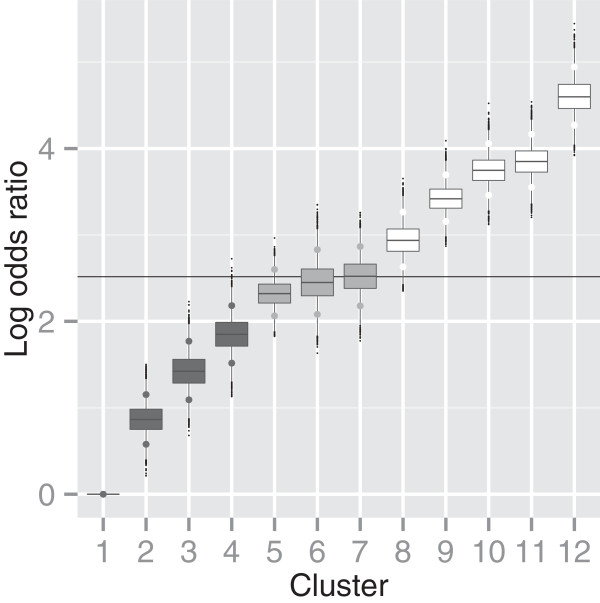
Log odds ratios of clusters. Log odds ratio relative to the non-smoking cluster 1, for the clusters in the representative clustering of the analysis with intensity, duration, time since cessation and pack years.